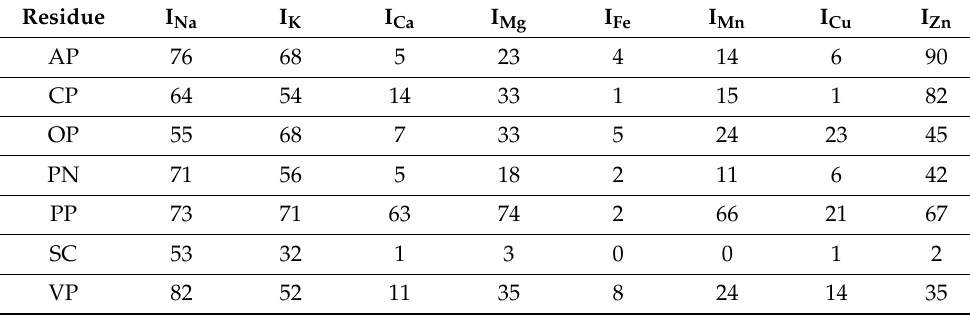
Table 7. Solubility index (%) of each nutrient (I N ).